Question: What kind of plot is shown here?
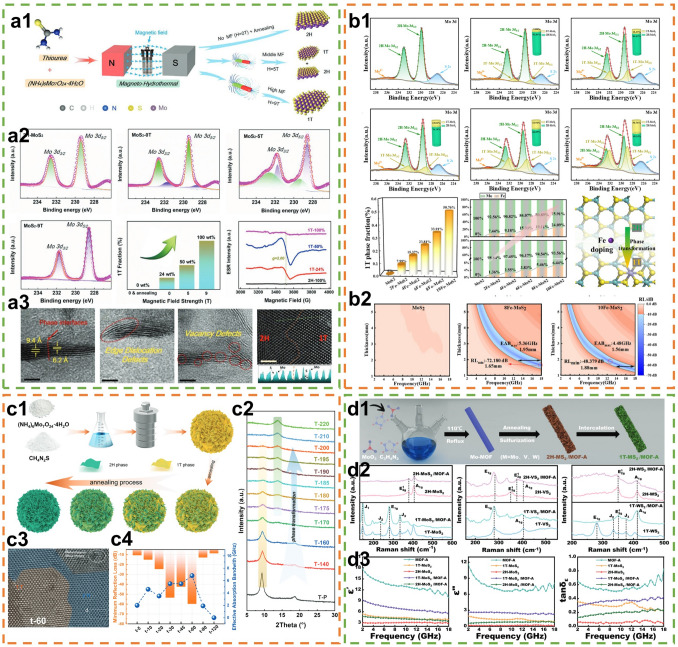
Answer: line